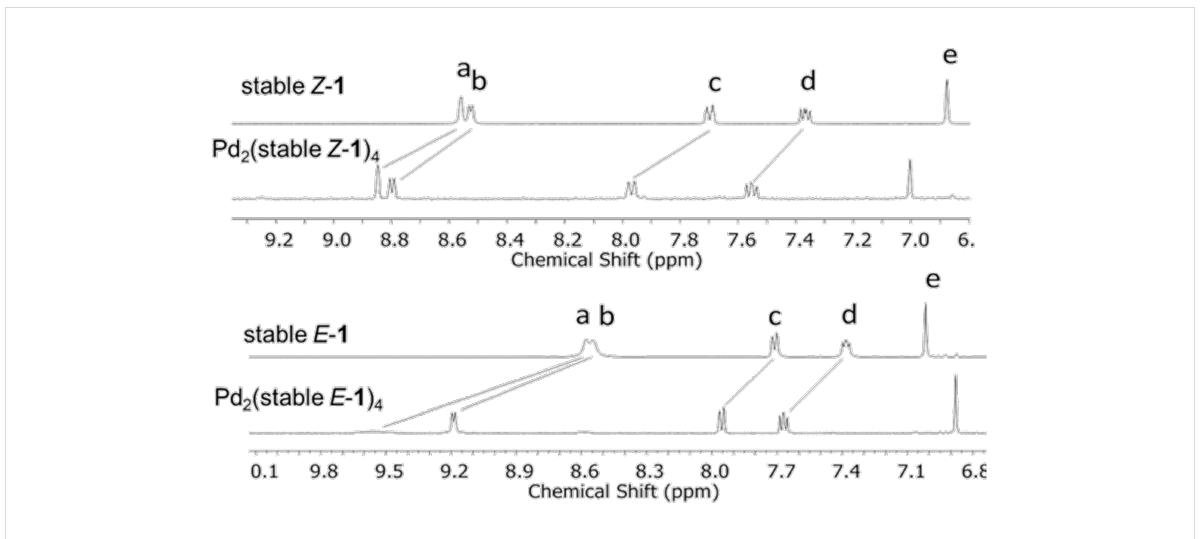
Figure 2: Aromatic region of stacked 1 H NMR spectra (in CD 3 CN) of stable Z - 1 and cage complex Pd 2 (stable Z - 1 ) 4 (top) and E - 1 and cage complex Pd 2 (stable E - 1 ) 4